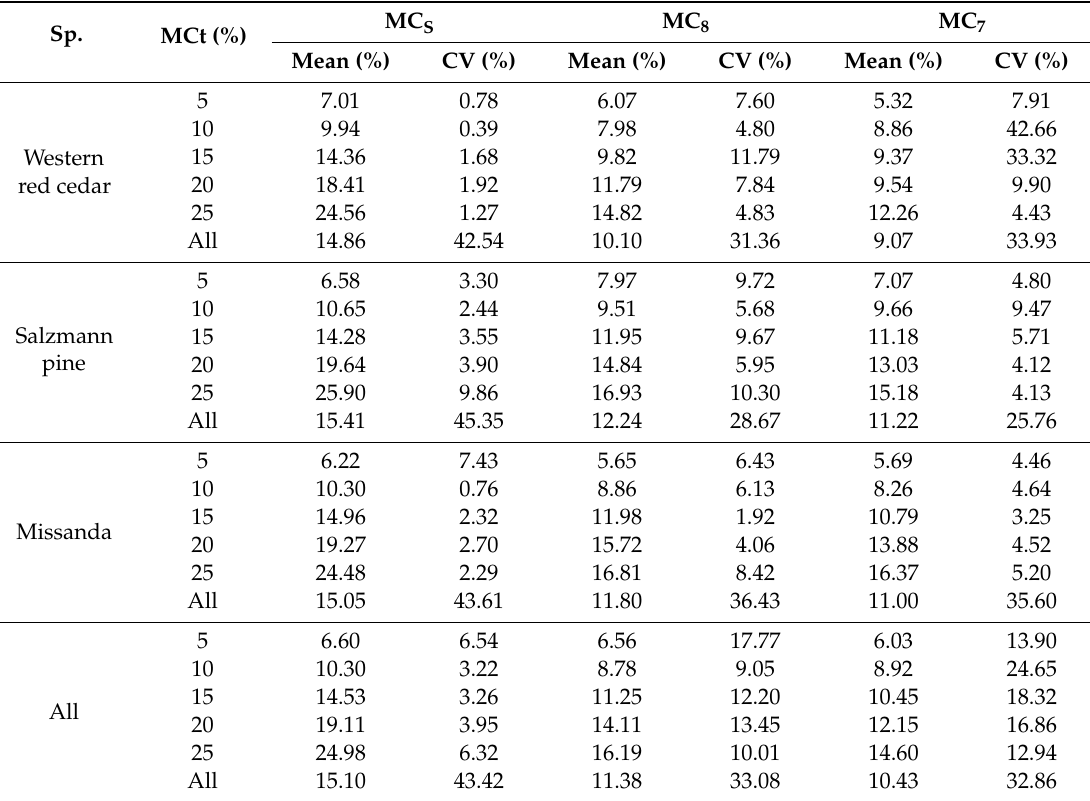
Table 5. Average values of the specimen’s moisture contents (MC S ), the chips extracted with the 8 mm drill bit (MC 8 ) and with the 7 mm drill bit (MC 7 ) and their coe ffi cients of variation for each species and MCt.